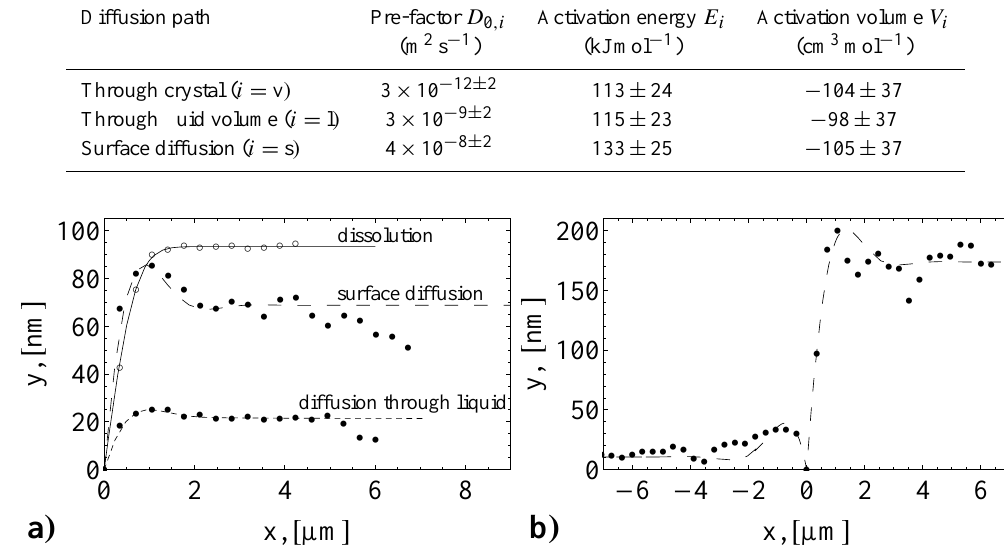
Figure 13. Fit of theoretical groove shape (according to Mullins’ theory) to individual groove profiles (points) observed for annealing experiments at (a) 392 ◦ C and 7.5h and (b) 392 ◦ C and 48h ( D s = 1 . 6 × 10 − 14 m 2 s − 1 , δ = 83 . 7 ◦ ). The line styles of the fitted model curves in (a) are chosen such that solid, long-dashed or short-dashed lines correspond to grooving kinetically controlled by dissolution (m[SiO 2 ] = 4 × 10 − 10 molkg − 1 , δ = 83 ◦ ), by surface diffusion ( D s = 3 . 6 × 10 − 14 m 2 s − 1 , δ = 77 ◦ ) or by diffusion through liquid ( D l = 9 . 5 × 10 − 14 m 2 s − 1 , δ = 86 . 5 ◦ ),